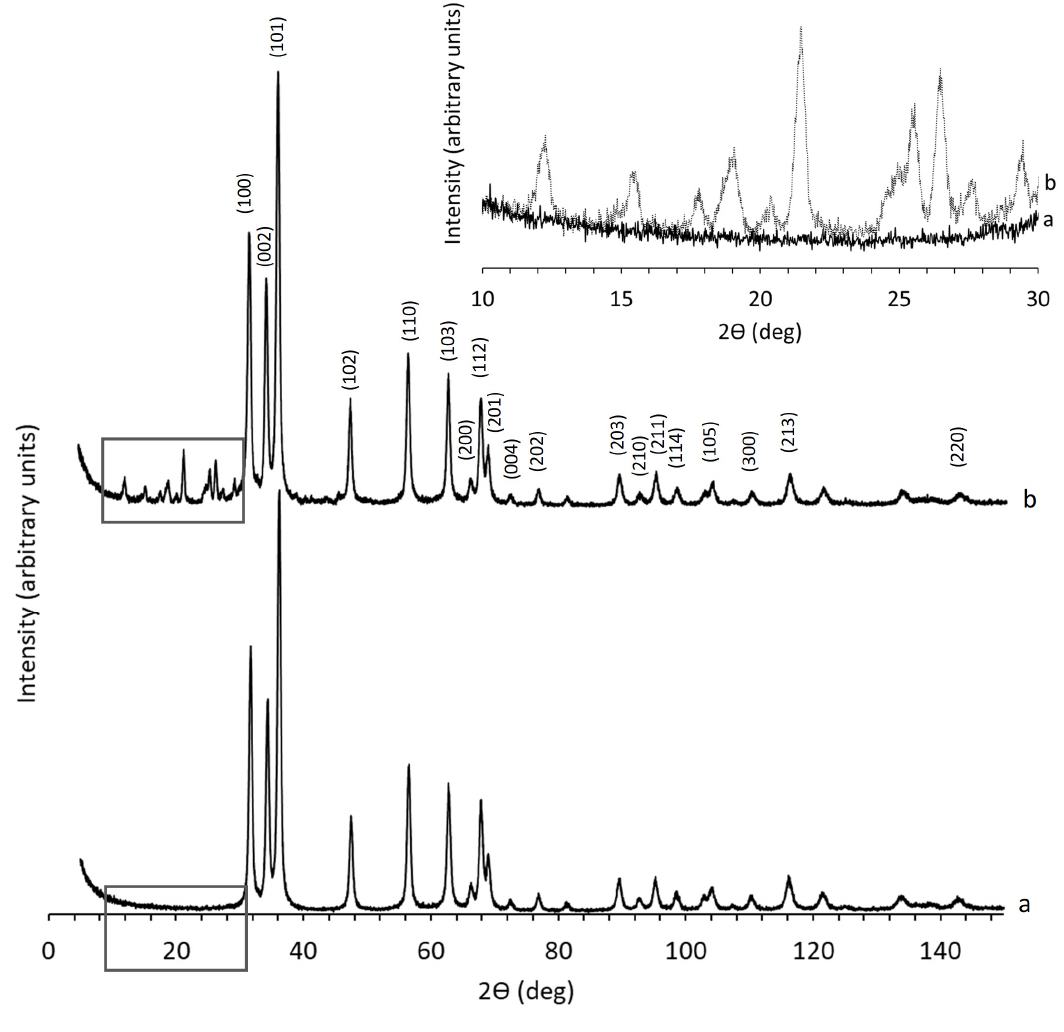
Figure 4. X-ray patterns recorded for samples ZnO, ZnO-PyQAs2-1% and ZnO-PyQAs2-2.5%— a (overlapped), and ZnO-PyQAs2-5%— b . Inset shows differences between a and b patterns in squared lined areas.